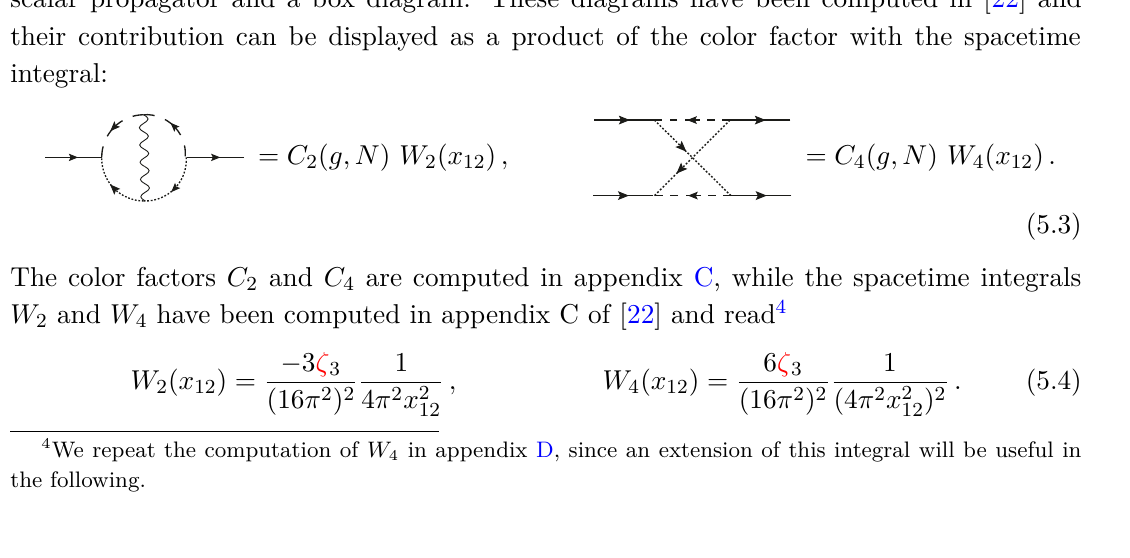
Figure 7. The diagram representing the insertion of a chiral operator O ( I ) x and of the corresponding anti-chiral operator of propagators arising from the insertion points is n